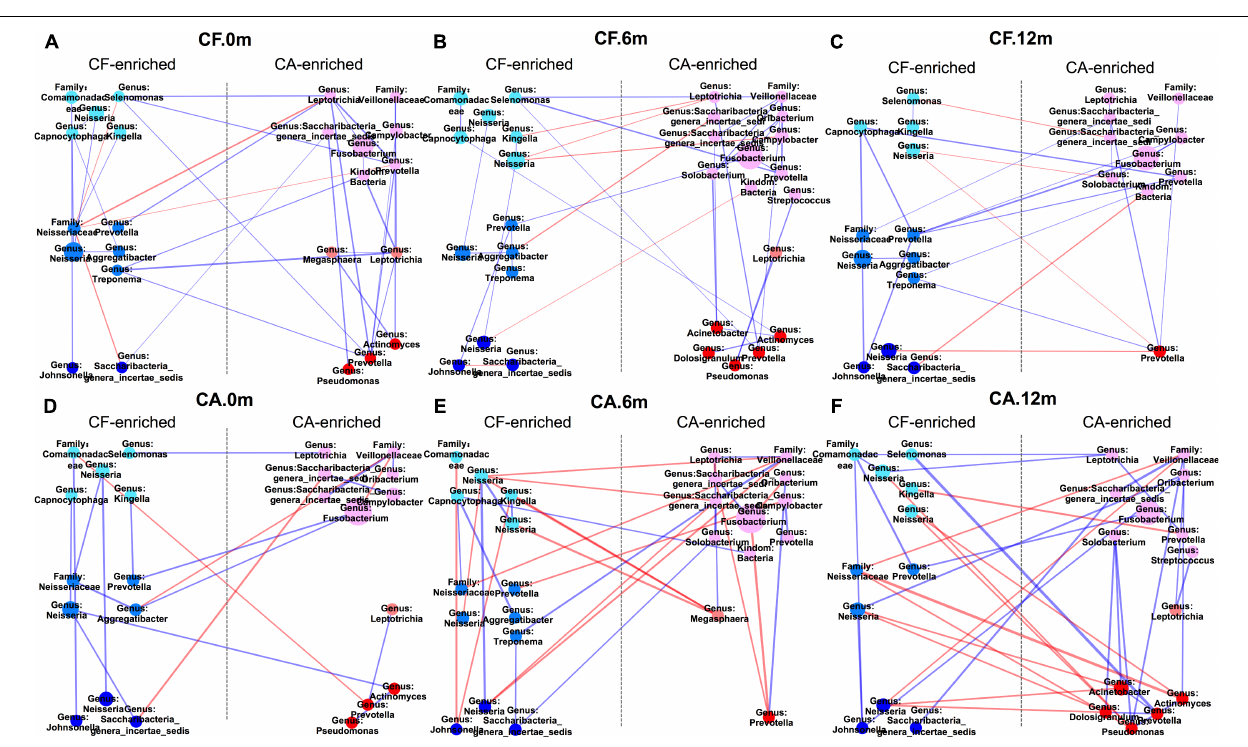
FIGURE 4 | Co-occurring network of caries-free (CF) enriched and caries enriched OTUs. Blue and red edges indicate positive ( r > 0.4) and negative correlations ( r < –0.4), respectively. The area of each node indicates the corresponding OTU’s relative abundance. The width of each line that connects two dots indicates the closeness extent of the correlation. The three colors on the left side from top to bottom represent CF-0m-enriched, CF-6m-enriched and CF-12m-enriched OTU; the three colors on the right side from top to bottom represent CA-0m-enriched, CA-6m-enriched, CA-12m-enriched OTU. (A–C) Co-occurring networks of CF-enriched and CA-enriched OTUs in supragingival microbiome of the CF group during follow-up. (D–F) Co-occurring networks of CF-enriched and CA-enriched OTUs in supragingival microbiome of the CA group during